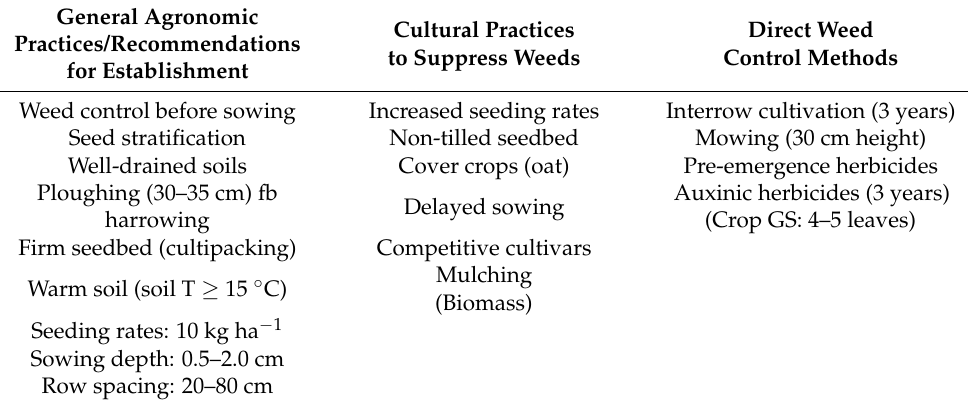
Table 2. General agronomic practices and recommendations for switchgrass establishment, cultural practices to suppress weeds and direct weed control